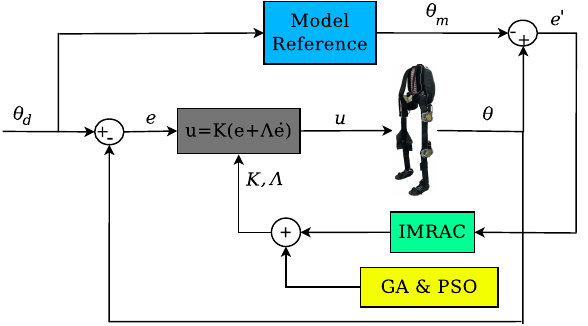
Figure 5. Block diagram of the IMRAC